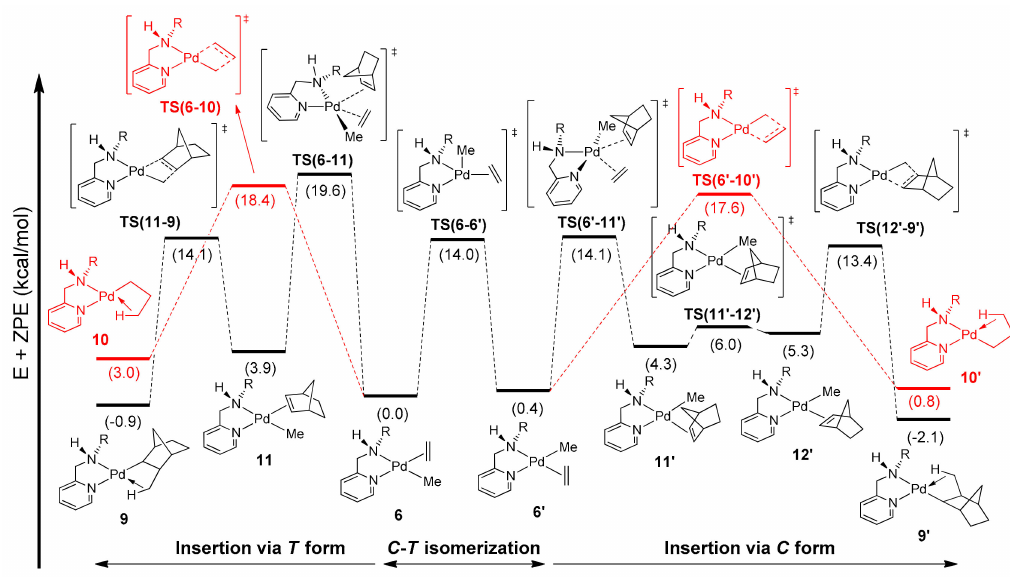
Figure 4. Energy profile for isomerization, ethylene, and norbornene propagation reaction of 6 and 6’ (E + ZPE, kcal/mol). (R = 2,6- i Pr 2 C 6 H 3